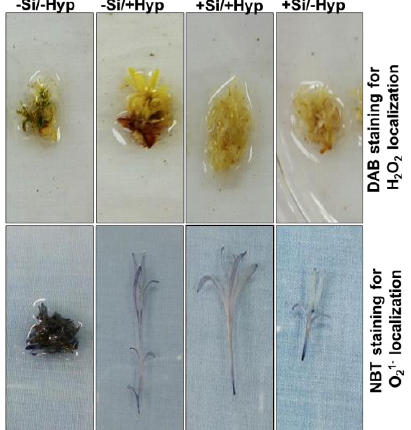
Figure 2. 3,3′-diaminobenzidine (DAB) nitro-blue tetrazolium (NBT) mediated localizations of H 2 O 2 and O 21- under hyperhydricity and silicon (Si) treatments (−Si/−Hyperhydricity; −Si/+Hyperhydricity; +Si/+Hyperhydricity; +Si/−Hyperhydricity) in shoot cultures of carnation ( Dianthus caryophyllus L.) grown in vitro .